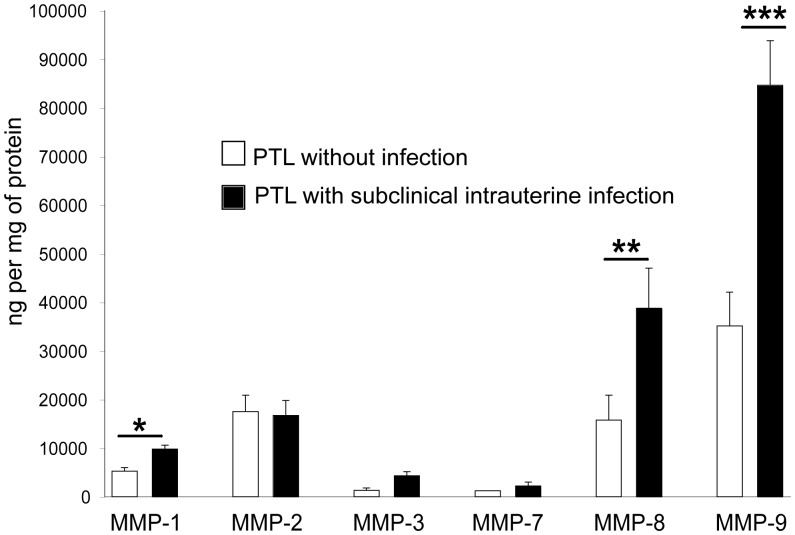
Profiles of matrix metalloproteinases secreted by cultured decidual cells from women with and without subclinical intrauterine infection.Concentrations of matrix metalloproteinases in the supernatants of decidual cells from women with preterm labor (PTL), with (n = 10) or without subclinical intrauterine infection (n = 25). Data are presented as mean±SD; experiments were performed in duplicate. ***P<0.001, **P<0.005, *P<0.05 as compared to PTL without infection.